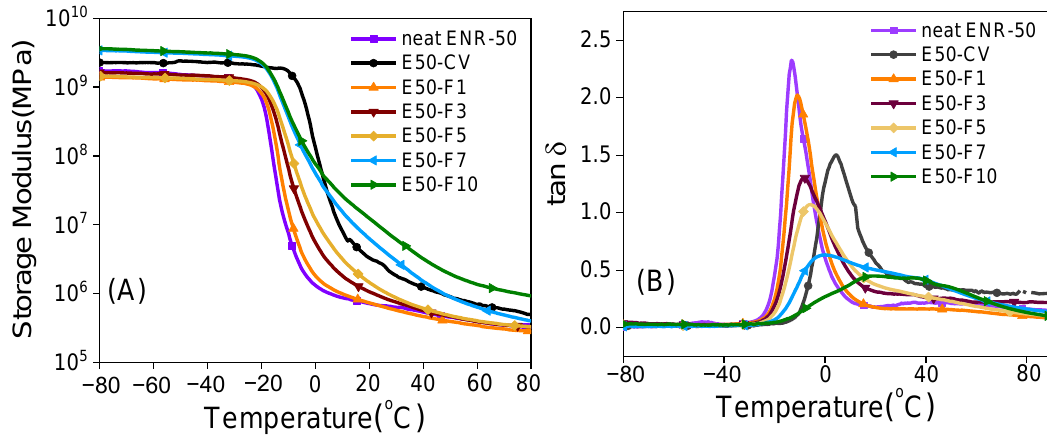
Figure 9. Storage modulus ( A ) and tan δ ( B ) as a function of temperature of the neat ENR-50, ENR-50 compounded with various concentrations of FeCl 3 compared and the conventional sulfur vulcanizate (i.e., E50-CV).